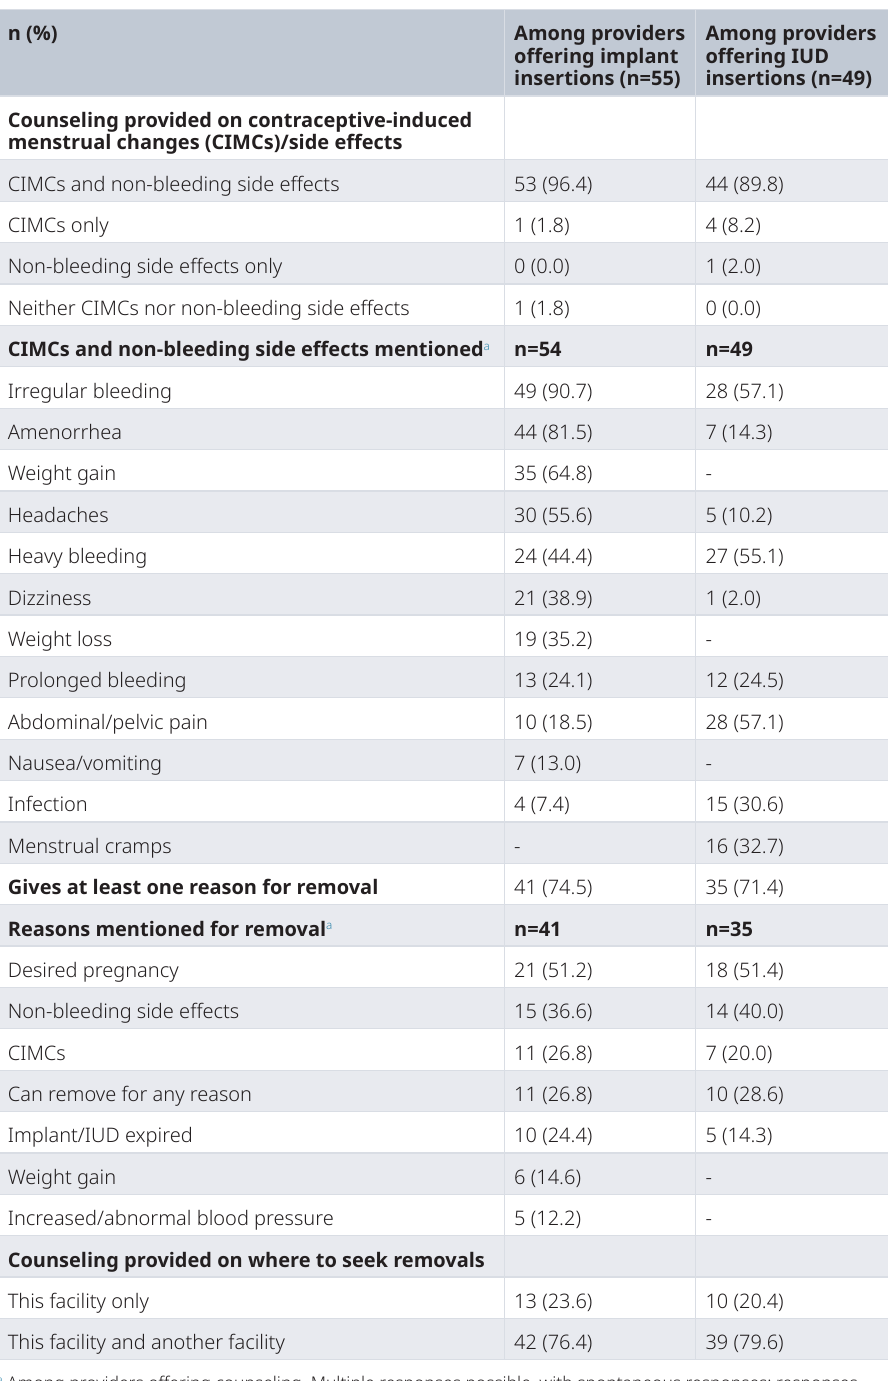
Table 2. LARC counseling provided at insertion among providers offering LARC insertions, by method. n (%) Among providers